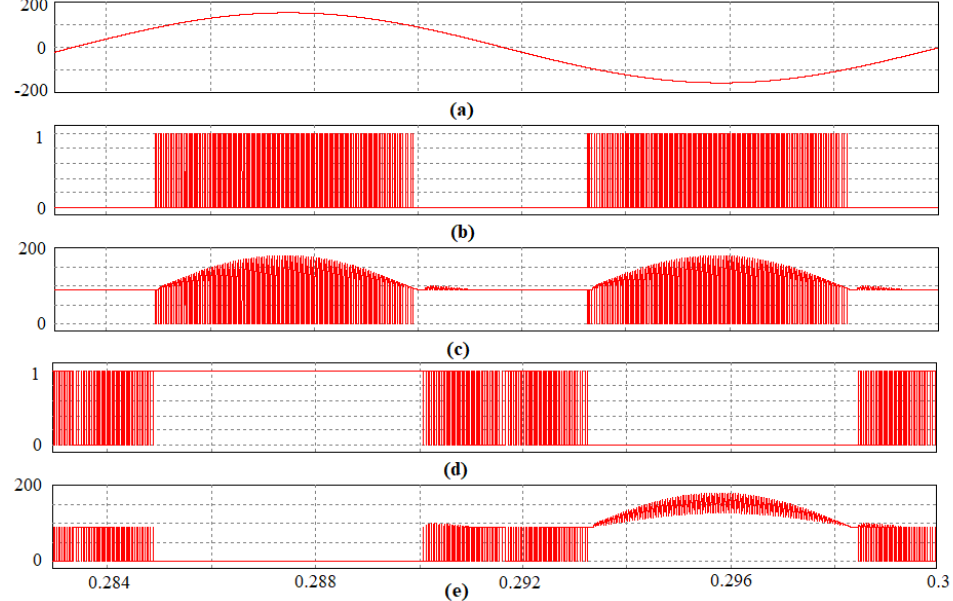
Figure 8. Voltage waveforms of S 1 and S 3 in a power grid cycle, ( a ) power grid voltage, ( b ) control signal of S 1 , ( c ) voltage across S 1 , ( d ) control signal of S 3 , ( e ) voltage across S 3 .